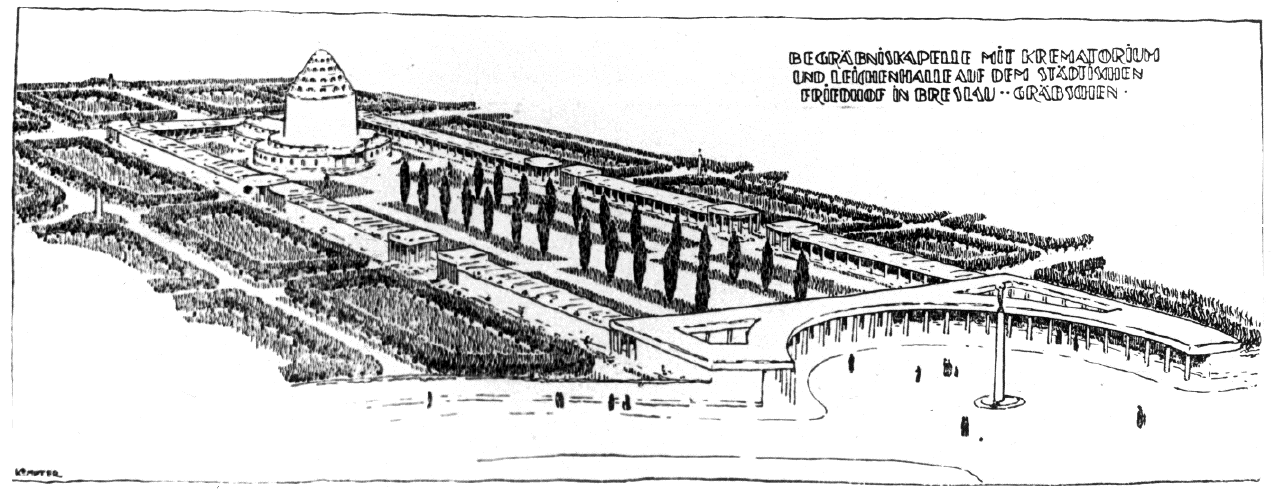
Figure 7. Funeral chapel with crematorium and mortuary designed by Max Berg, in the municipal cemetery in Breslau Gräbschen (Deutschland Städtebau Breslau, Berlin, 1921, p. 41).